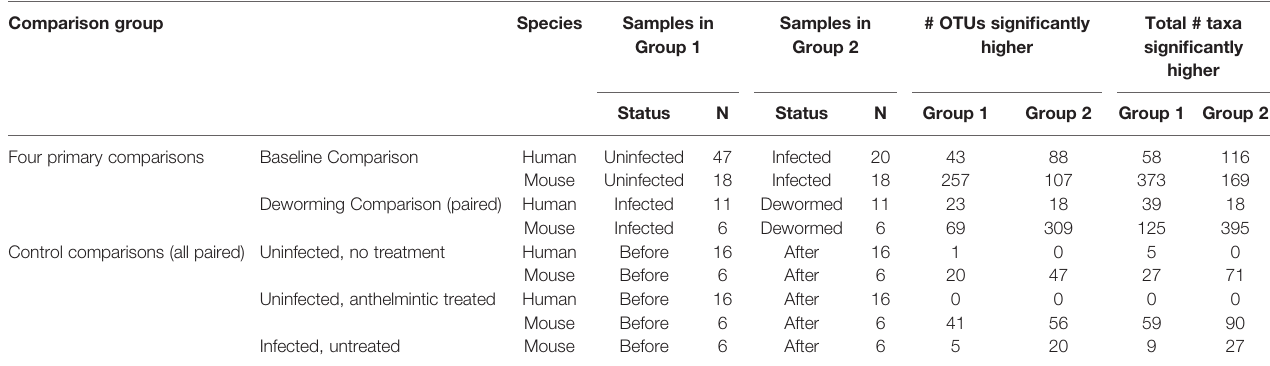
TABLE 2 | Summary of sample groups used for each statistical comparison, and the counts of the number of signi fi cant OTUs and taxa at any taxonomic level, based on LEfSe results. Comparison